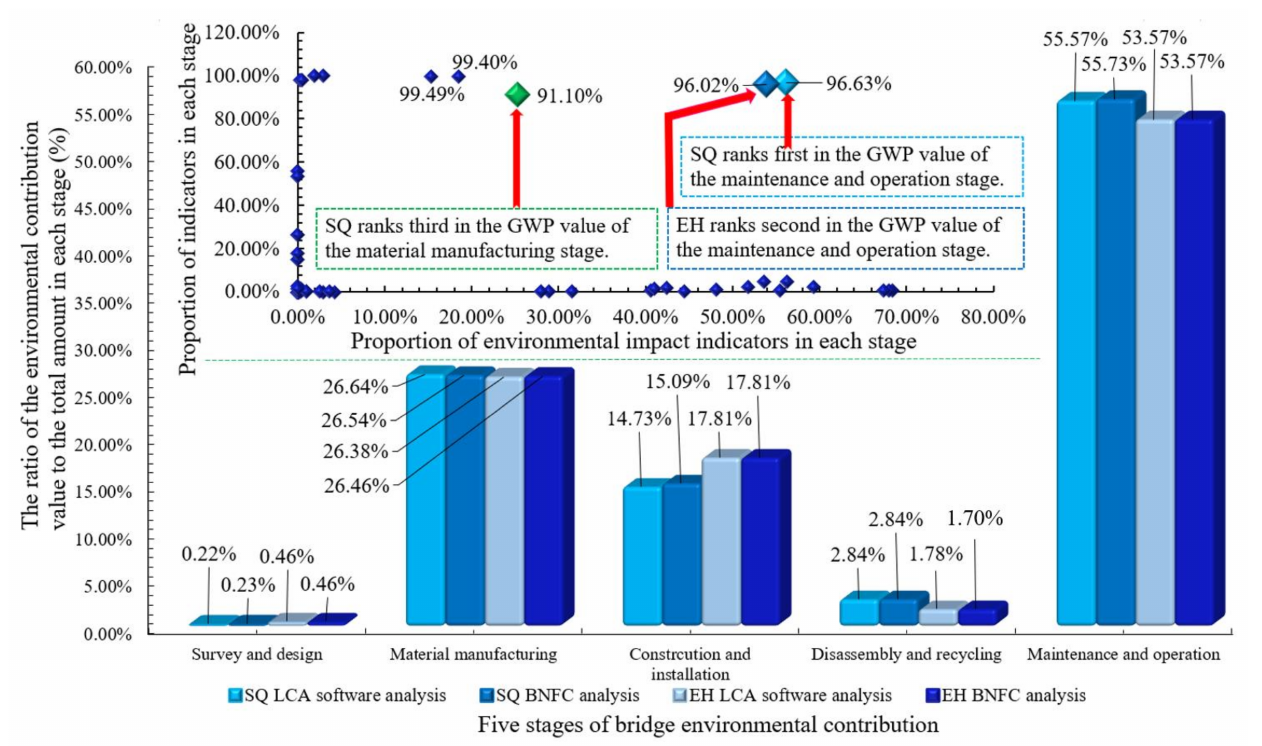
Figure 9. Comparison of the conclusions of using two methods to study the environmental impact contribution of SQ and